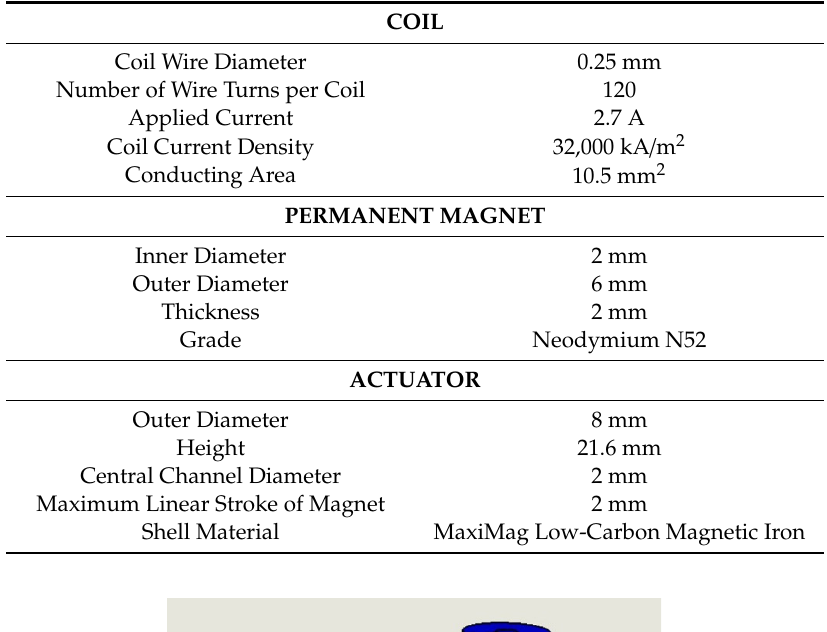
Table 1. Representative design parameters of the prototype actuator.